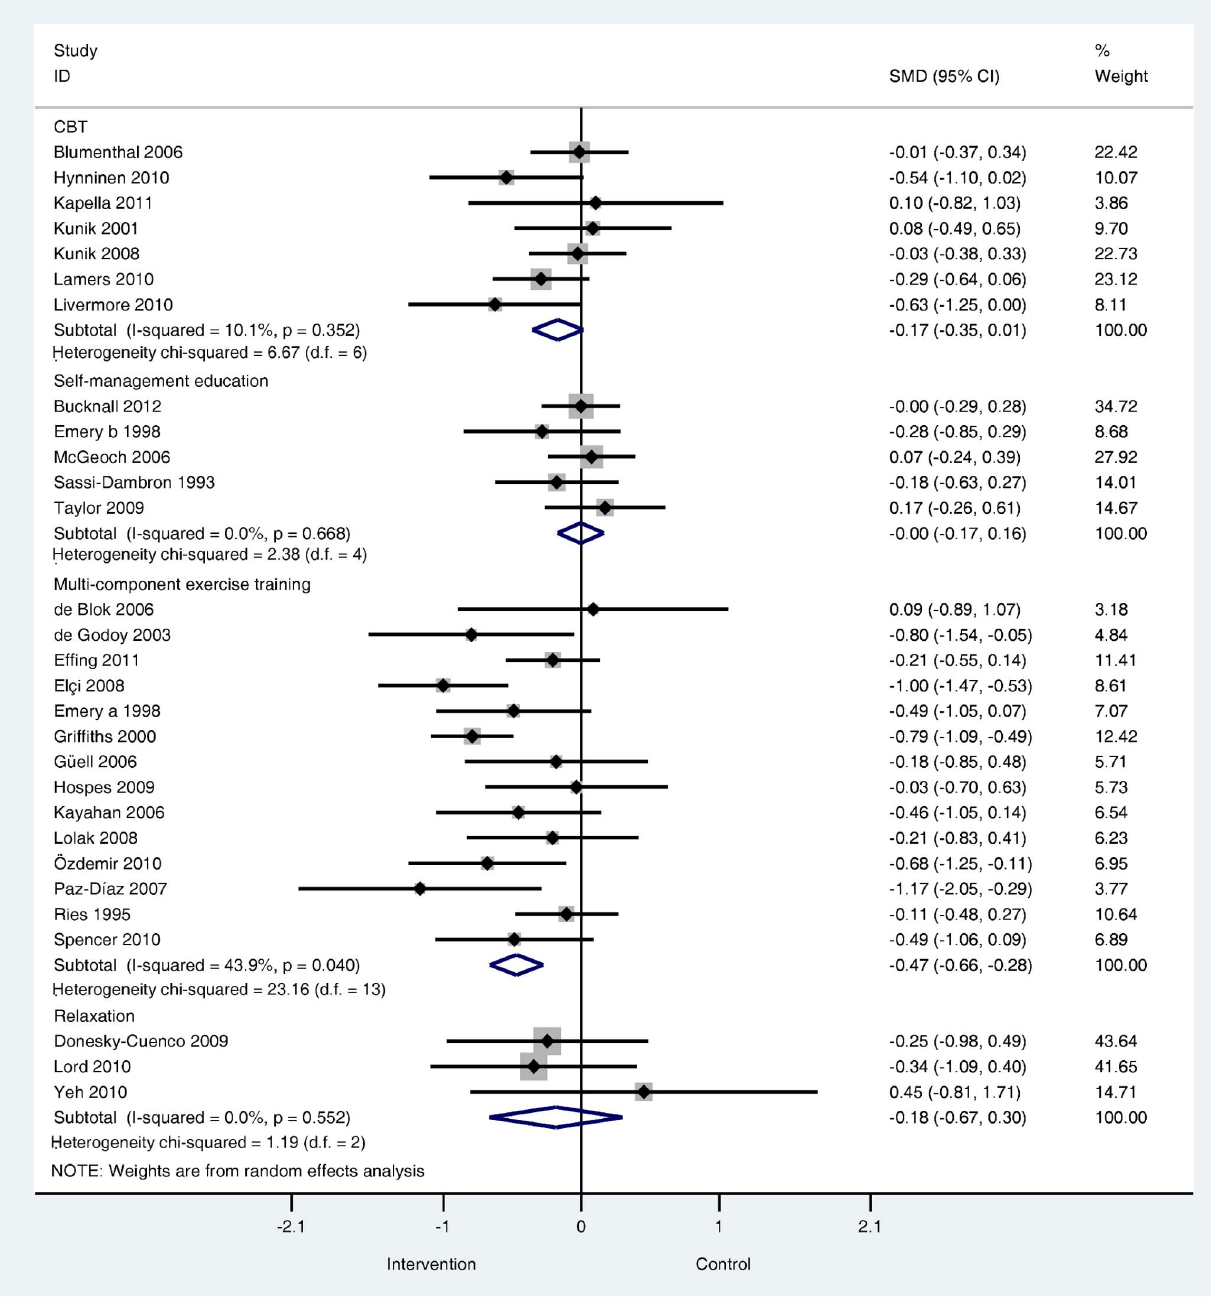
Figure 6. Effects of complex interventions by sub-group on self-reported symptoms of depression at post-treatment. Note: Random effects model used. 95% CI=95% confidence interval; SMD=standardised mean difference.